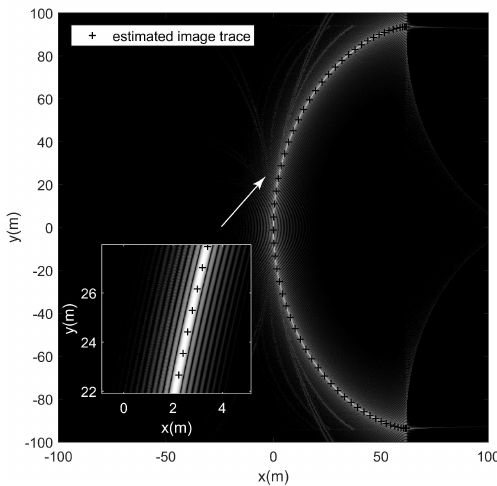
Figure 11. Estimated image trace and moving target SAR